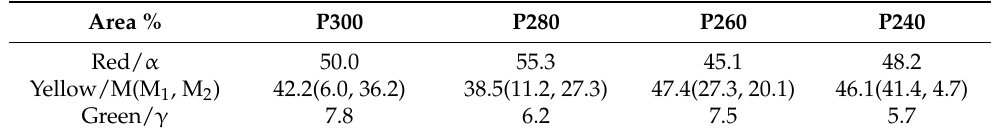
Figure 3. SEM images of IPP treatment at different partition temperatures: ( a ) P300; ( b ) P280; ( c ) P260; ( d ) P240. Table 2. Areas corresponding to different color regions.